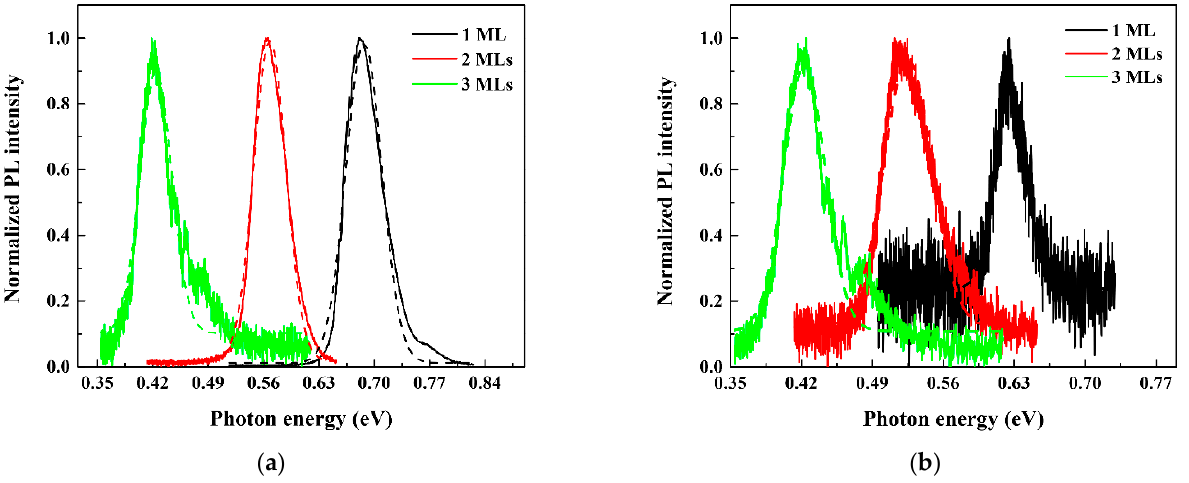
Figure 6. Normalized PL intensities of 1, 2, and 3 MLs of InAs/GaSb MQW for ( a ) 77 K and ( b ) 300 K.